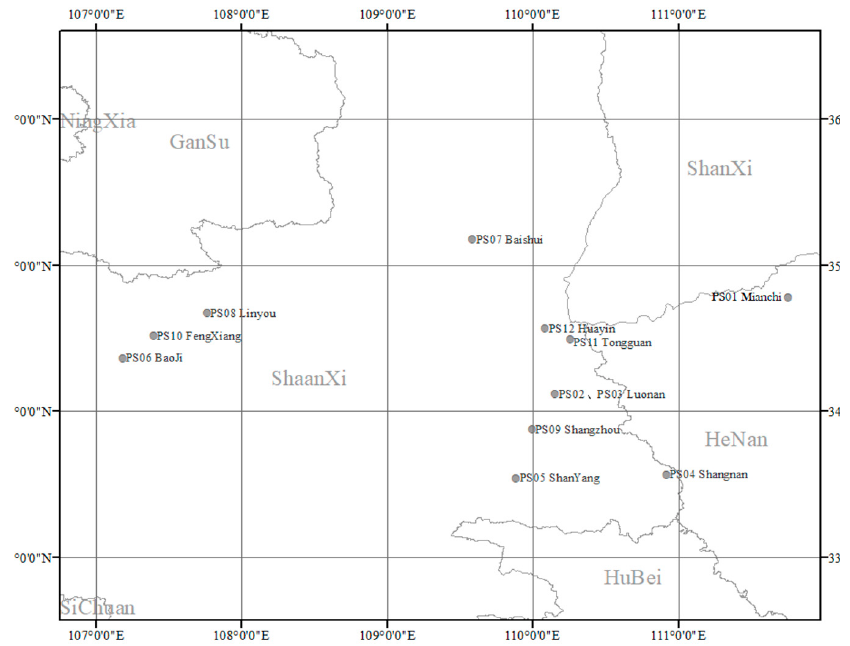
Figure 6. Geographic information of PS01–PS12.